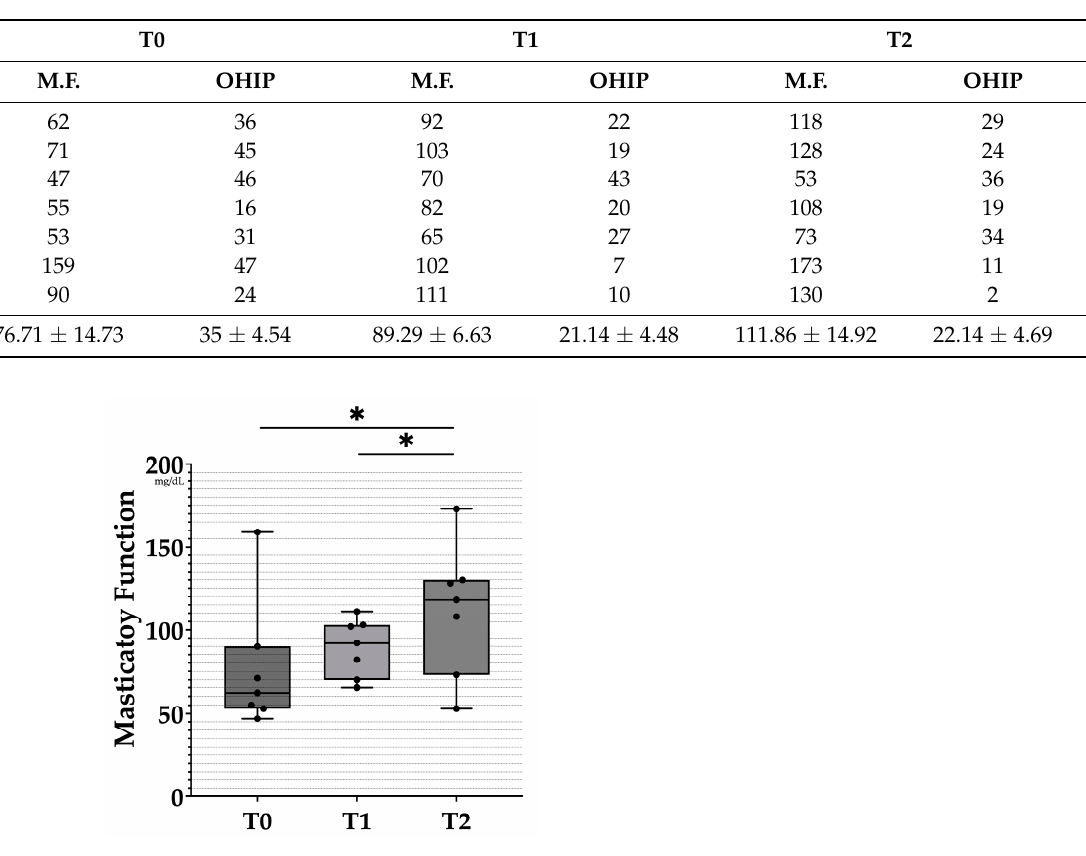
Table 1. General characteristics of analyzed cases. CD: complete denture. RPD: removable partial